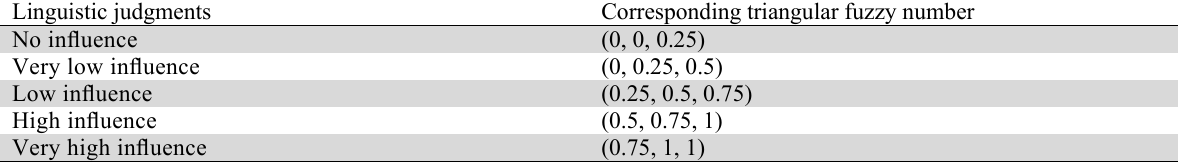
Corresponding relationship between language and fuzzy